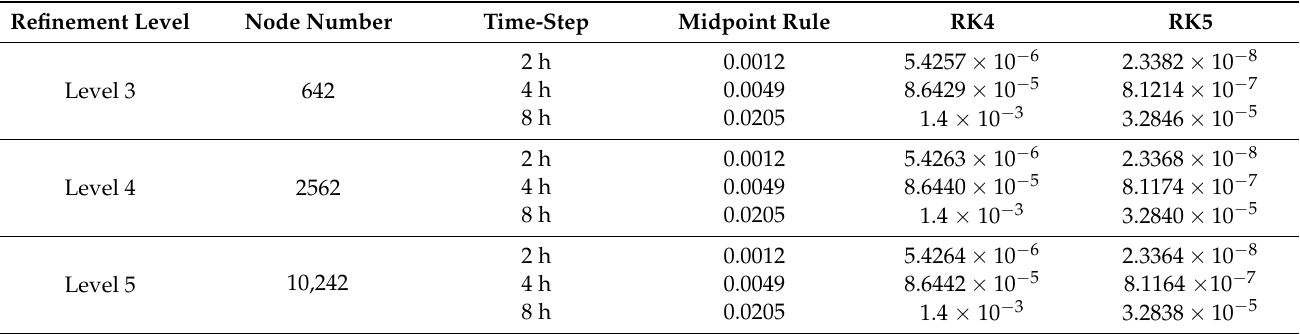
Table 2. The comparison for departure points’ location error between exact solution and these of three different